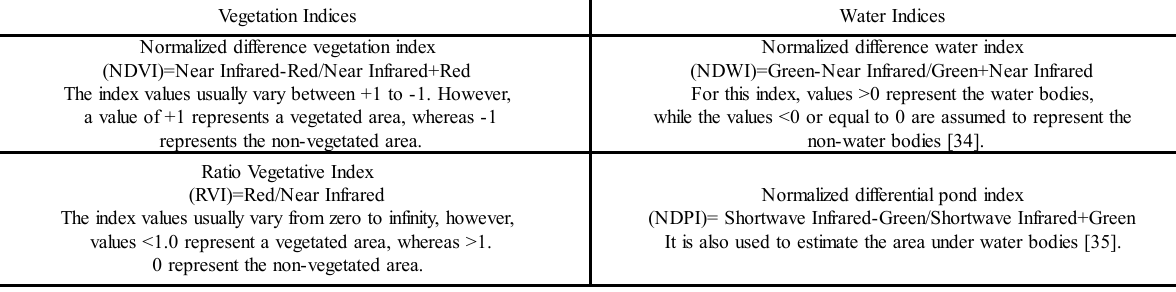
TABLE 2. DESCRIPTION OF VEGETATION AND WATER